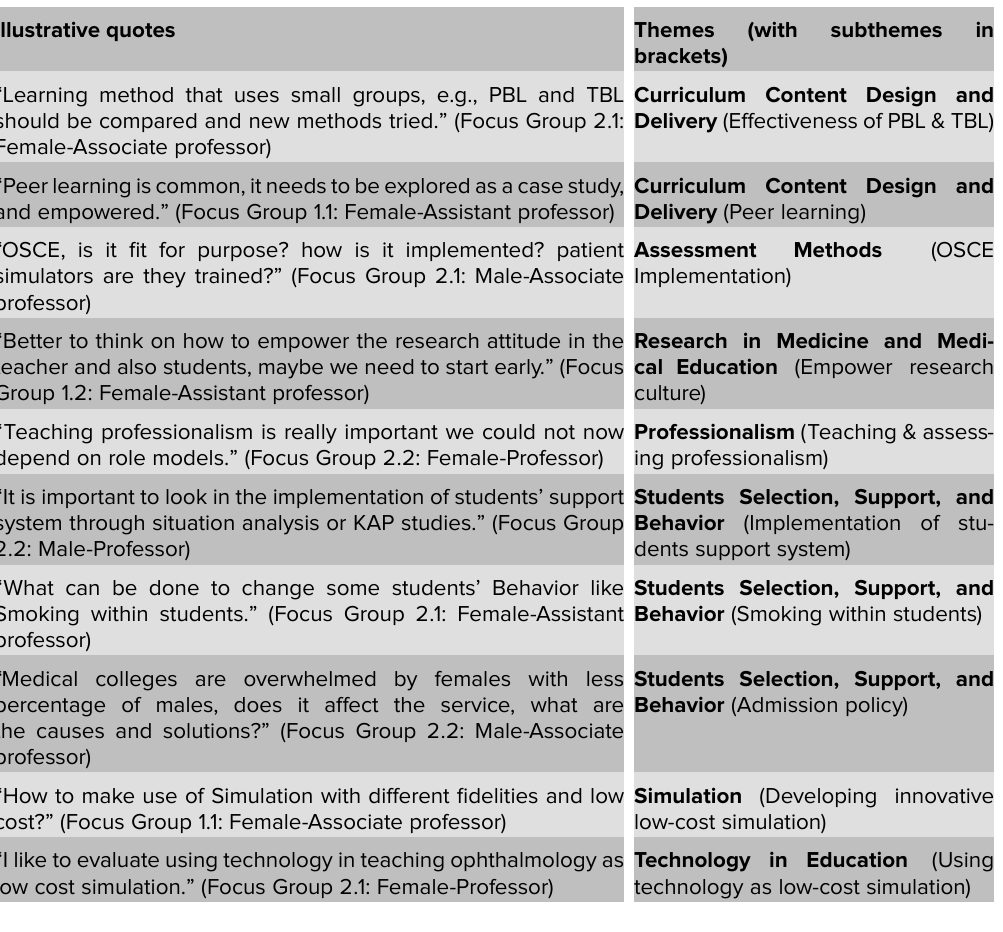
Table 2: Illustrative quotes with relevant themes and subthemes: Learners’ focused